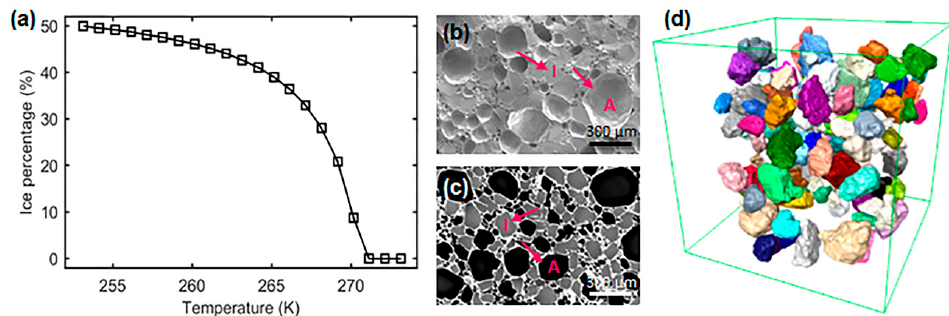
Figure 1. The characteristics of ice crystals in ice cream samples: ( a ) ice crystal volume fraction as a function of temperature; ( b ) a typical cryo-SEM image, showing air cells, A, and ice crystals, I; ( c ) 2D X-ray tomographic image of an ice cream sample. Note, the contrast was enhanced via edge-constrained diffusion filtering (300 iterations). Dark features are air cells, grey features are ice crystals and white regions are the unfrozen matrix; ( d ) 3D renderings of the ice crystals from X-ray tomographic images, providing a 3D view of the features. Here, the ice crystals are individually color rendered (after Reference [2]).